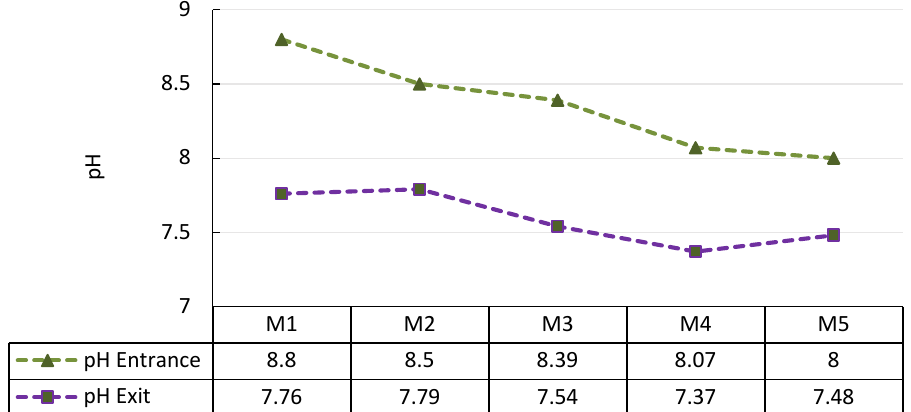
Fig. 3: Temperature of the treated and untreated effluents in the 5 sampling